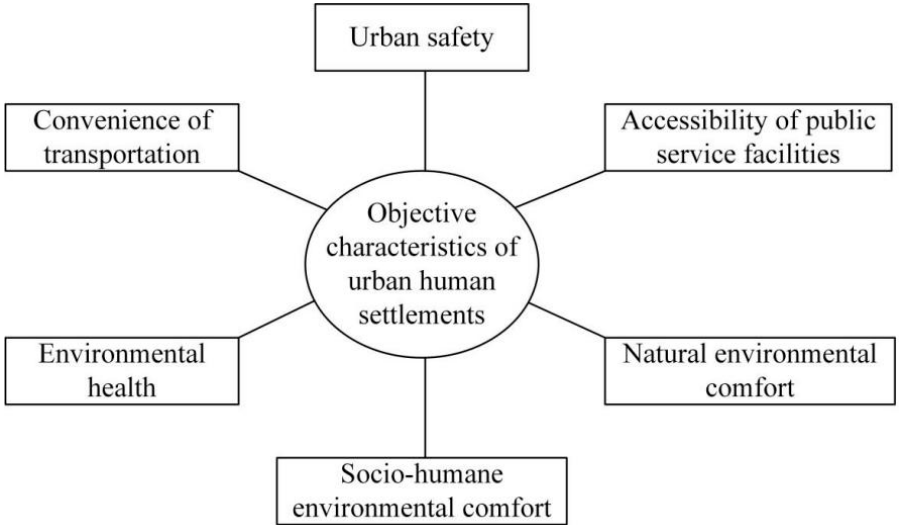
Figure 2. Connotation of the objective characteristics of the urban living environment.